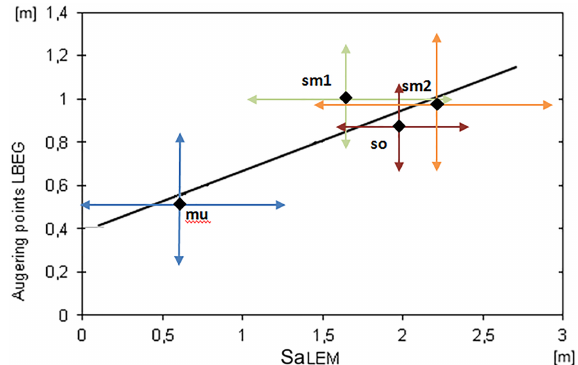
Figure 11. The average thickness values (m) of the augering points compared to the average values of the SaLEM model run within the geological units of the validation rectangle: Lower Muschelkalk (mu), Upper Buntsandstein (so), Middle Buntsandstein 2 (sm2) and Middle Buntsandstein 1 (sm1). The arrows indicate the standard de- viation values of the respective data sets.